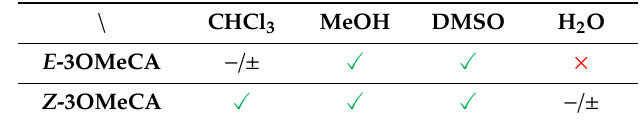
Table 1. Qualitative solubility tests for E -3OMeCA and Z -3OMeCA a . \ CHCl 3 MeOH DMSO H 2 O E -3OMeCA − / ± (cid:88) (cid:88)